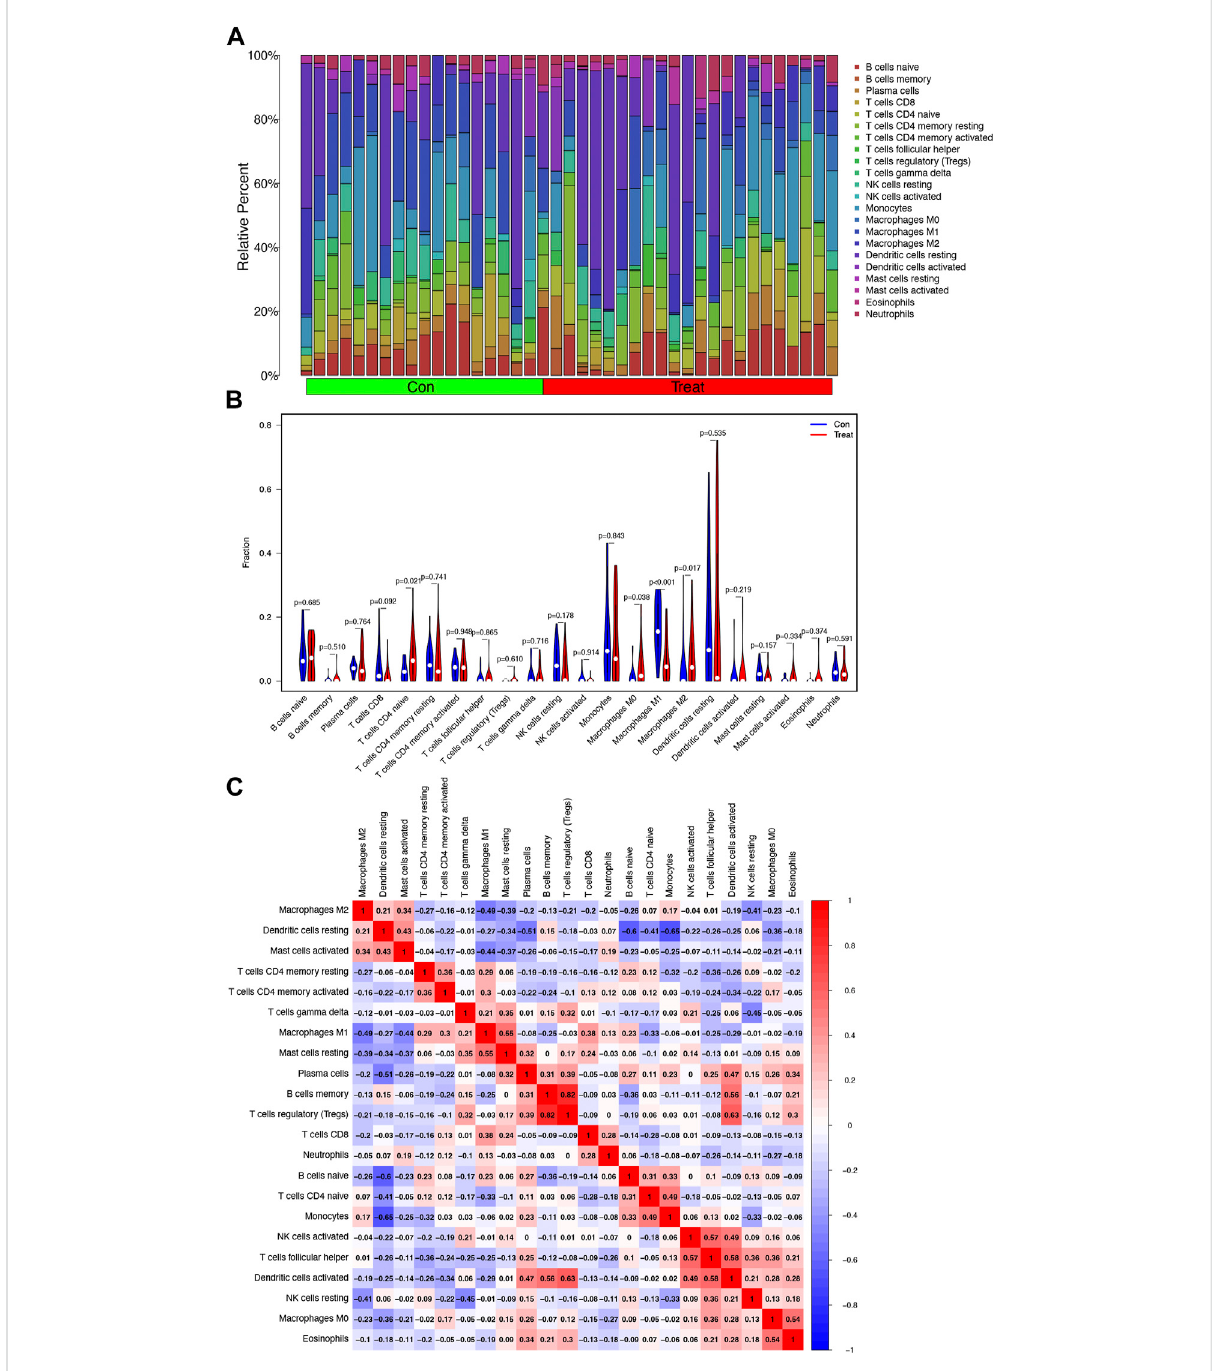
FIGURE 6 Analysis of in fi ltrating immune cells in the training cohort. (A) Heatmap of relative fraction of 22 representative immune cell population in the Con(normal)andTreat(HCC)cohortswasdisplayed. (B) Boxplotsshowedthecoresof22immunecellsbetweentheCon(normal)andTreat(tumor) cohorts. (C) Heatmap of correlation between 22 immune